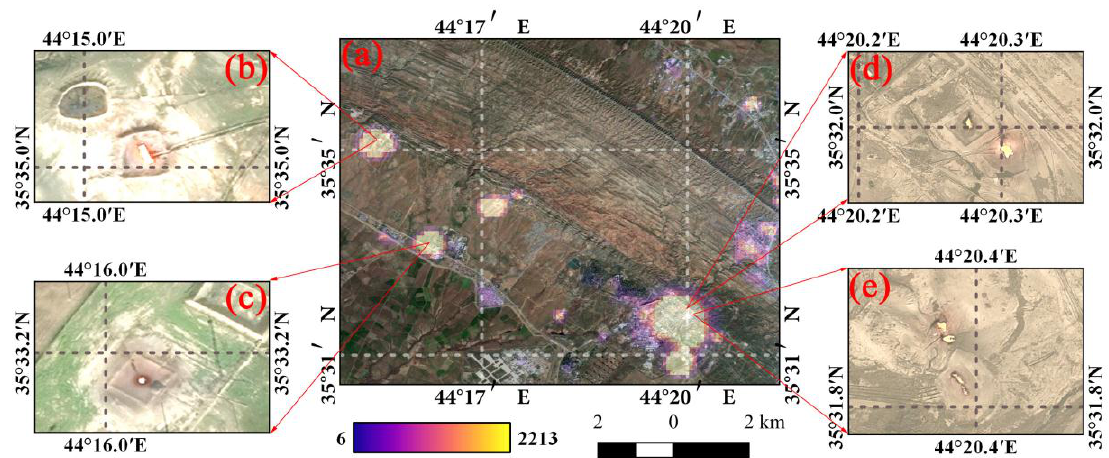
Figure 14. The gas fire captured by Luojia 1-01 nighttime light imagery in Iraq: ( a ) is the nighttime light image overlaid on a Google Earth high-resolution image with 50% transparency; ( b – e ) are the gas fires shown in Google Earth high-resolution images.